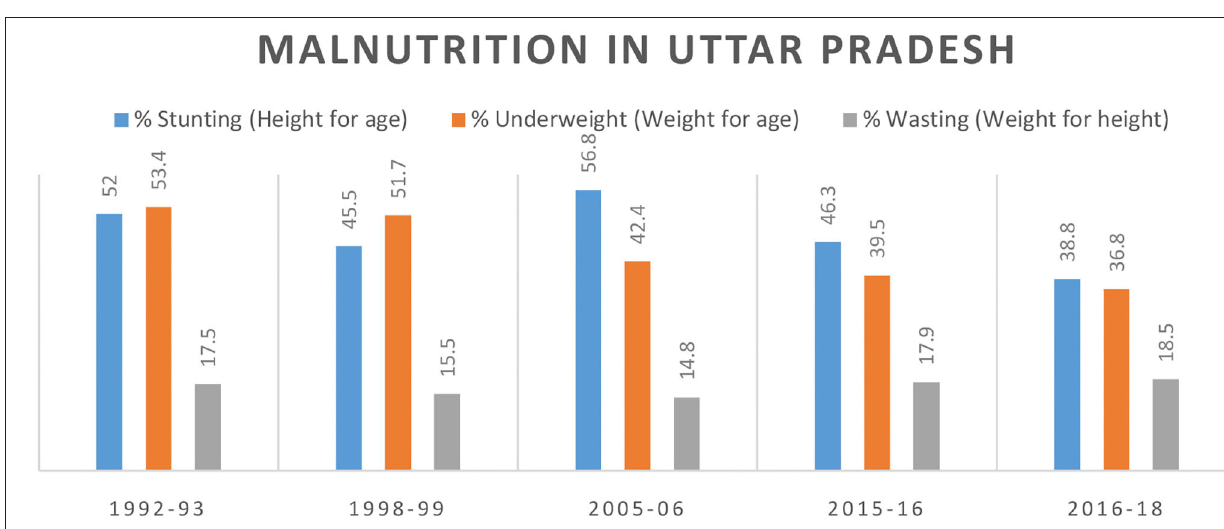
use of presumptive treatment of azithromycin or doxycycline for febrile illness helped in managing and reducing the JE and ST cases which caused overall decline in AES